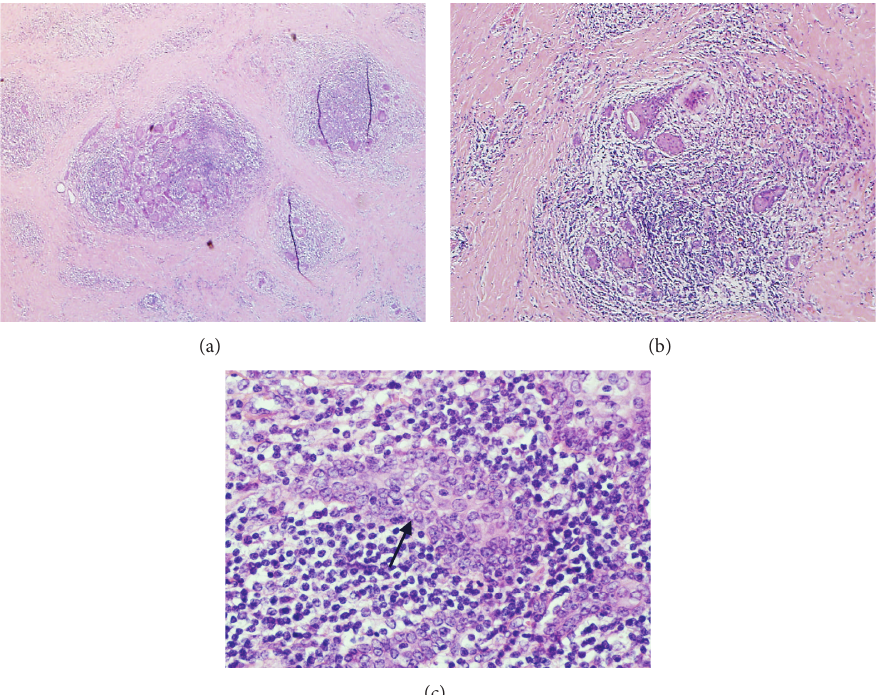
Figure 1: (a) Medium magnification: obliteration of architecture by dense fibrosis. (b) High magnification: chronic inflammatory infiltrate, squamousmetaplasia,andnuclearfeaturesofpapillarythyroidcarcinoma.(c)Highermagnification:papillarythyroidcancercellswithtypical nuclear changes (indicated by